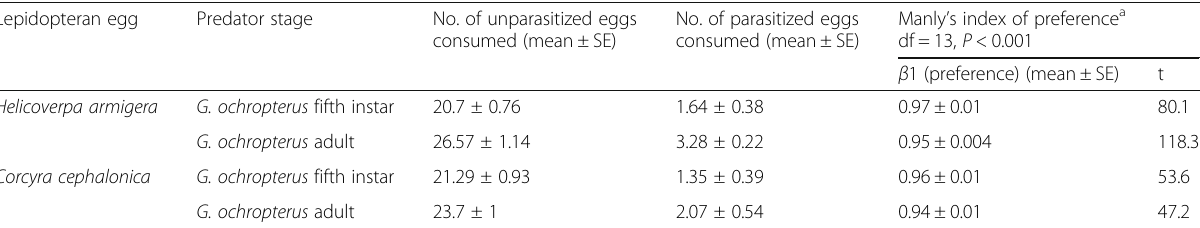
Table 1 Numbers of Helicoverpa armigera and Corcyra cephalonica eggs consumed and Manly ’ s index of preference for nymph and adult of Geocoris ochropterus given a choice of unparasitized and parasitized eggs by Trichogramma chilonis Lepidopteran egg